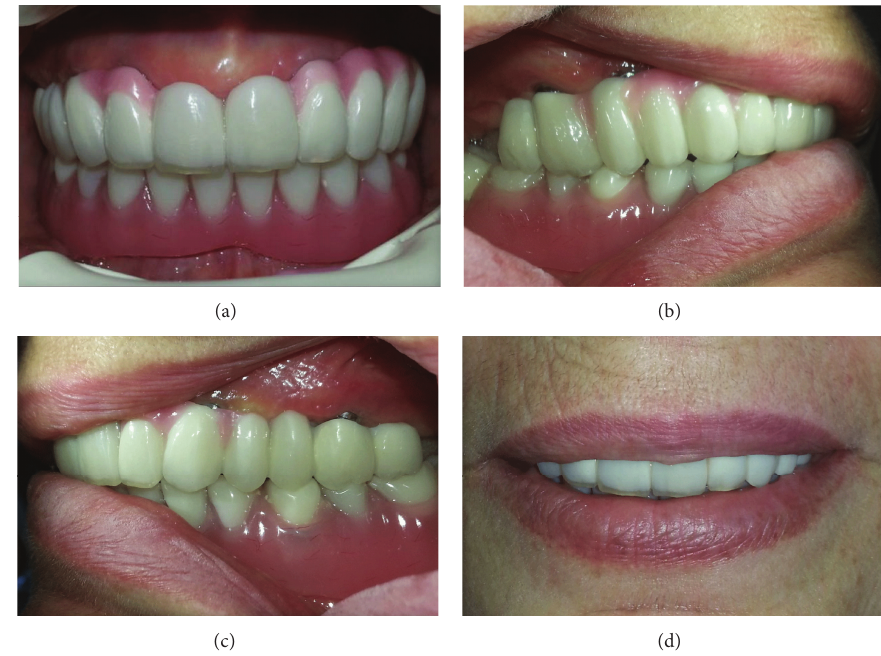
Figure 5: (a) Intraoral, ((b), (c)) sagittal, and (d) frontal views of the case after